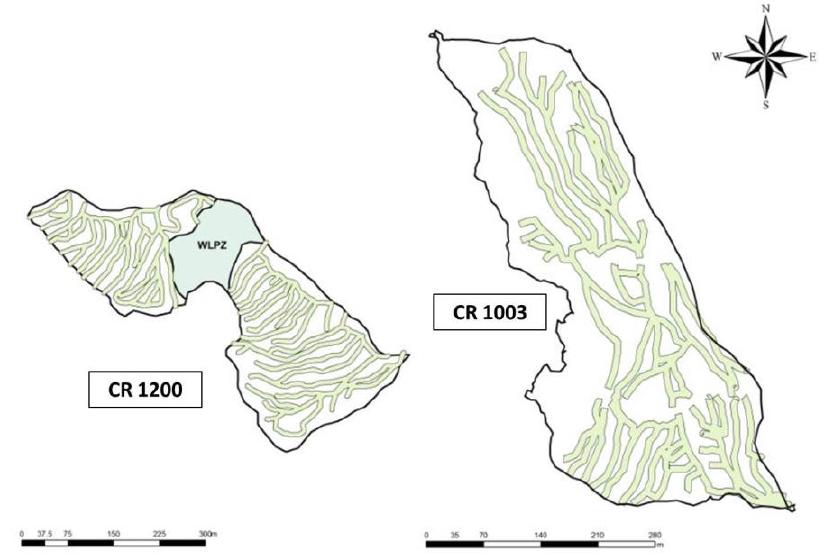
Figure 1. Map of the study sites and forwarding trails used by cut-to-length (CTL) systems. Table 1. Stand composition characteristics including average diameter at breast height (DBH), height, trees per hectare (TPH), basal area (BA), and species distribution (percent of stand) before thinning.